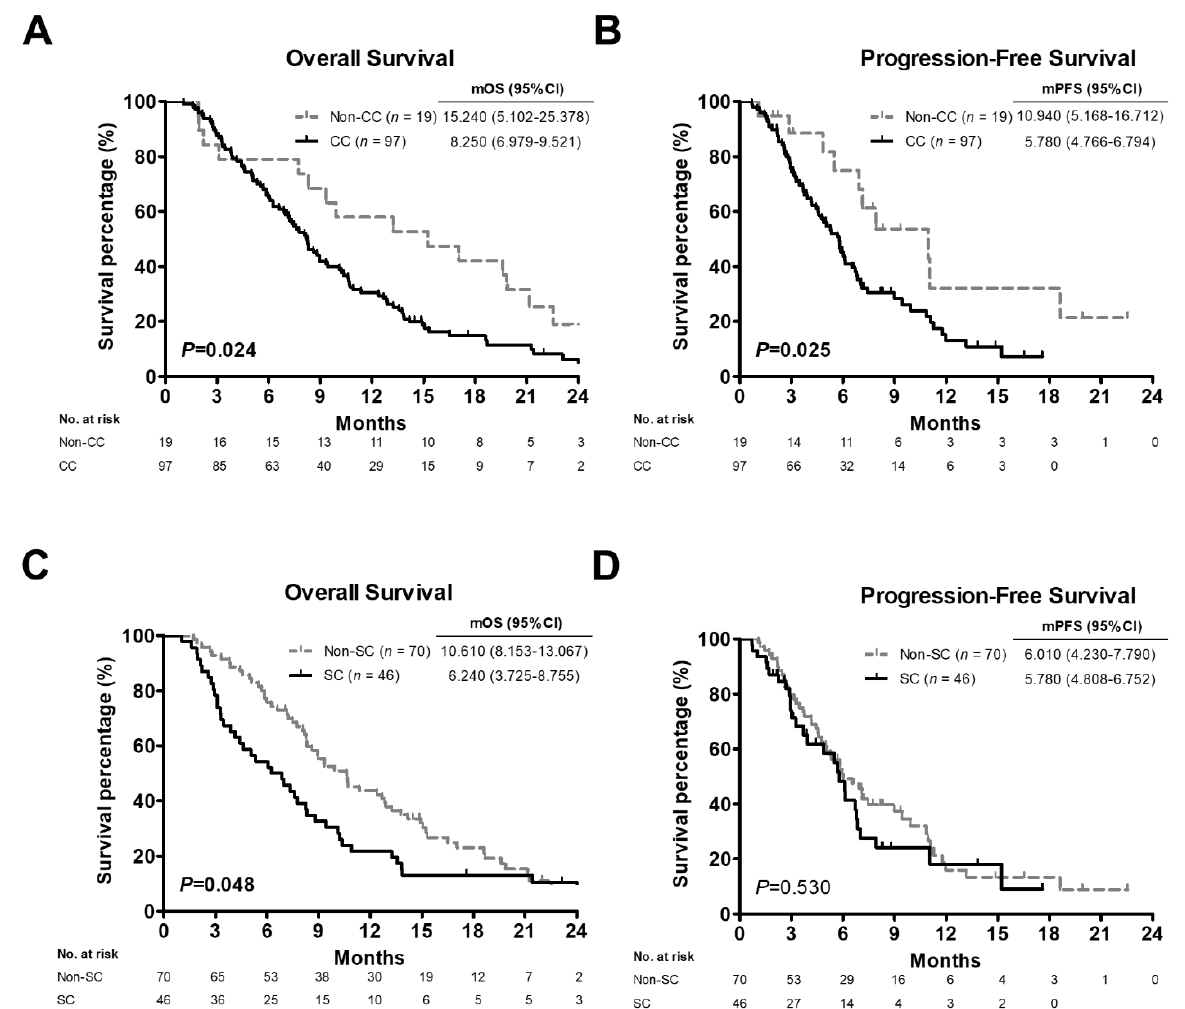
Figure 4. Kaplan-Meier analysis plotting the survival curves of 116 pancreatic cancer patients with BMI > 22 according to cancer cachexia or sarcopenia status. ( A , C ) Overall survival curves of patients with BMI > 22 stratified by cancer cachexia ( A ) or sarcopenia ( C ). ( B , D ) Progression-free survival curves of patients with BMI > 22 stratified by cancer cachexia ( B ) or sarcopenia ( D ). p values deter- mined using the log-rank test. BMI, body mass index; CC, positive cancer cachexia status; Non-CC, negative cancer cachexia status; SC, positive sarcopenia status; Non-SC, negative sarcopenia status; mOS, median overall survival; mPFS, median progression-free survival; CI, confidence interval.